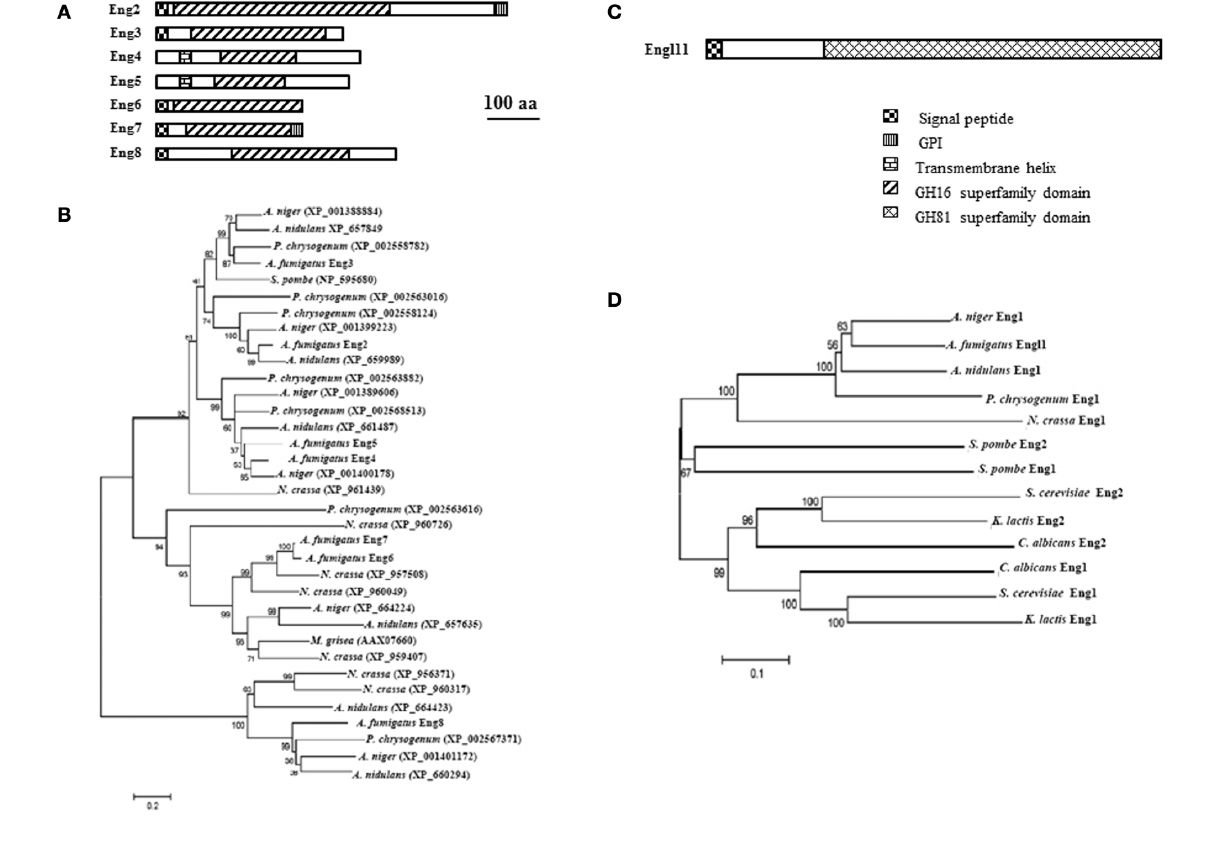
amino acids). (A) GH16 family domain organization and (B) phylogeny of GH16 family (C) GH81 family domain organization and (D) Phylogenetic tree of GH81